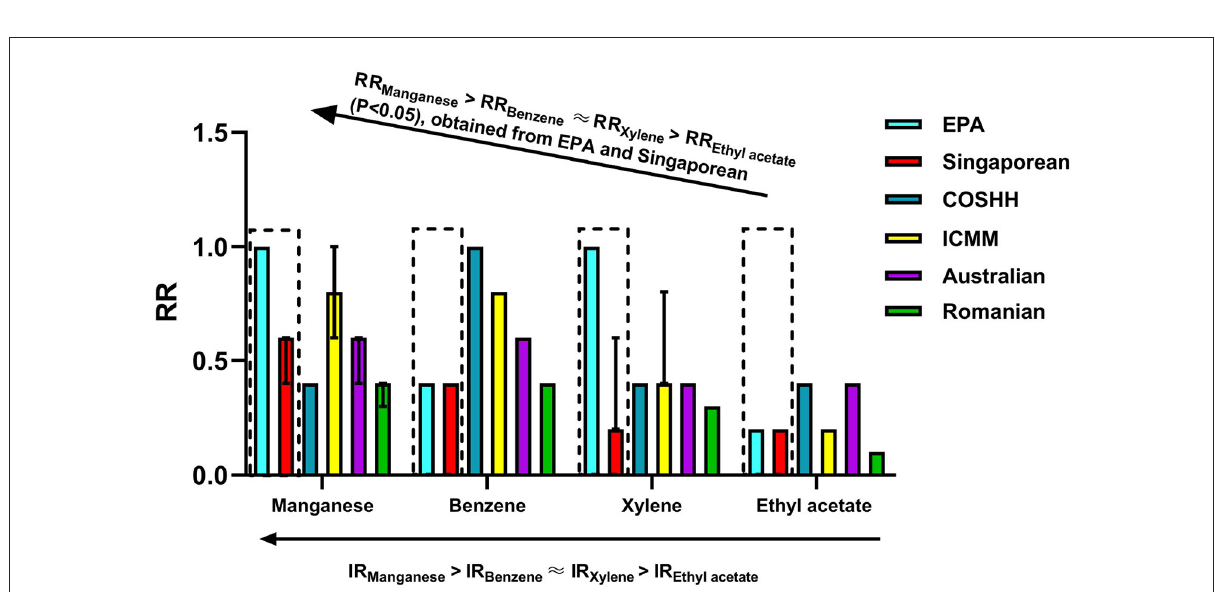
FIGURE2 Quantitative comparison of the RRs obtained for four hazard factors (manganese and inorganic compounds, benzene, xylene, and ethyl acetate) using the six methods [median (interquartile spacing)]. The IR order of the four hazard factors in the five industries was: IR manganese > IR benzene ≈ IR xylene > IR ethylacetate . The EPA and Singaporean models effectively distinguished the inherent risks (IRs) among the four hazard factors using the RRs ( P < 0.05). According to the EPA method, the RRs order of the four hazard factors was: RR manganese > RR xylene > RR benzene > RR ethylacetate ( P < 0.05), while that for the Singaporean method was: RR manganese > RR benzene > RR xylene > RR ethylacetate ( P < 0.05).